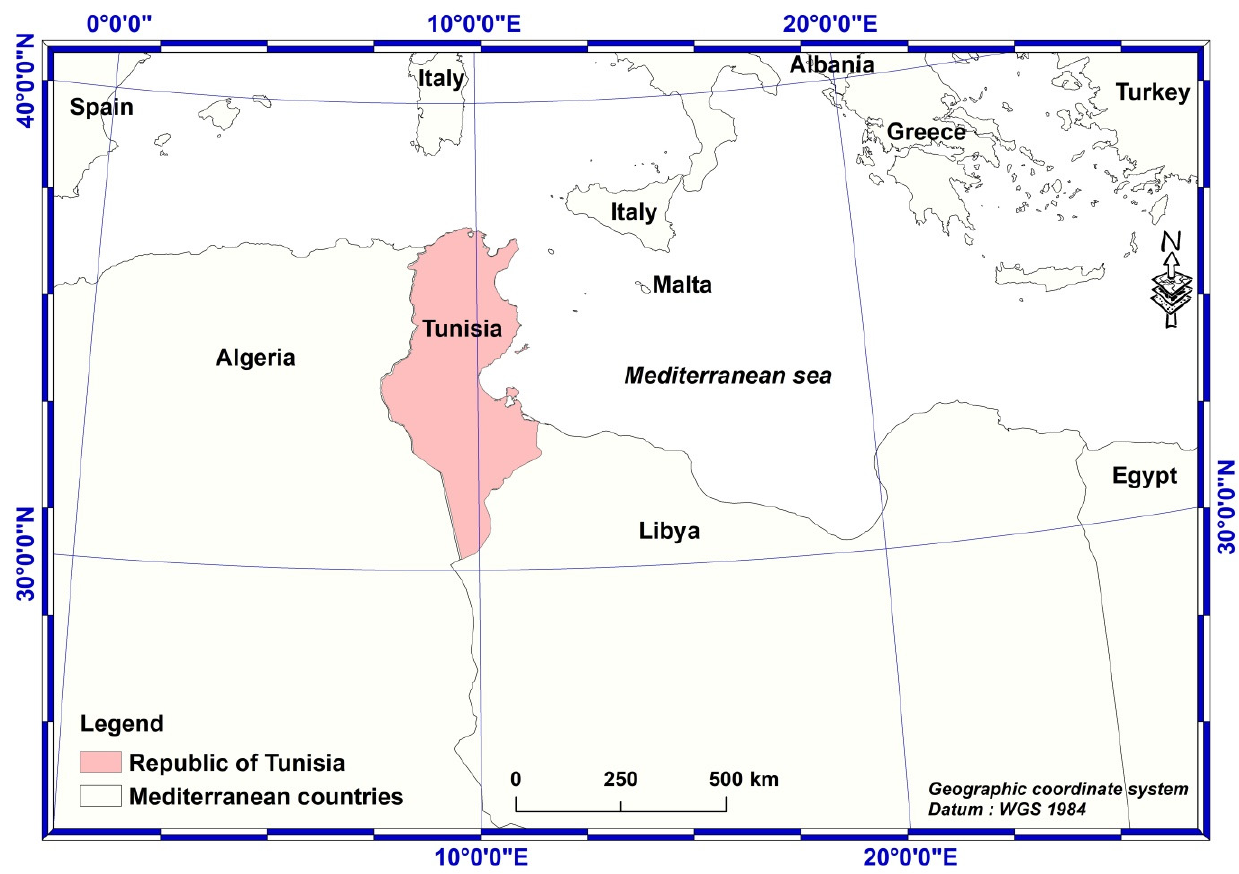
Figure 1. Map of the study area.